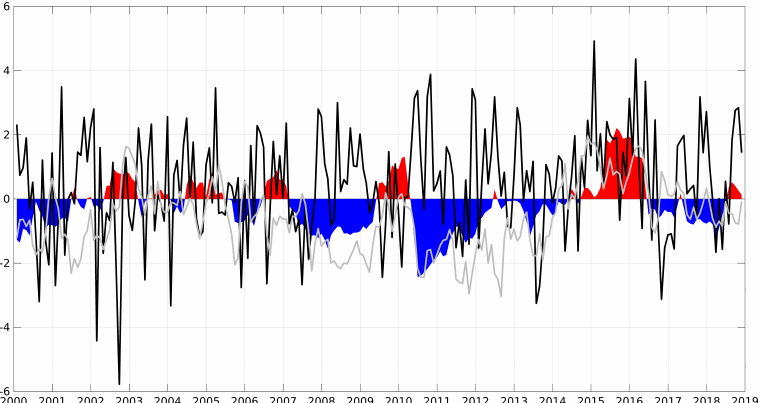
Figure A2. Time series of Climate indices: Multivariate ENSO Index (MEI; red/blue), Southern Annular Mode (SAM; black line), and Pacific Decadal Oscillation (PDO; grey